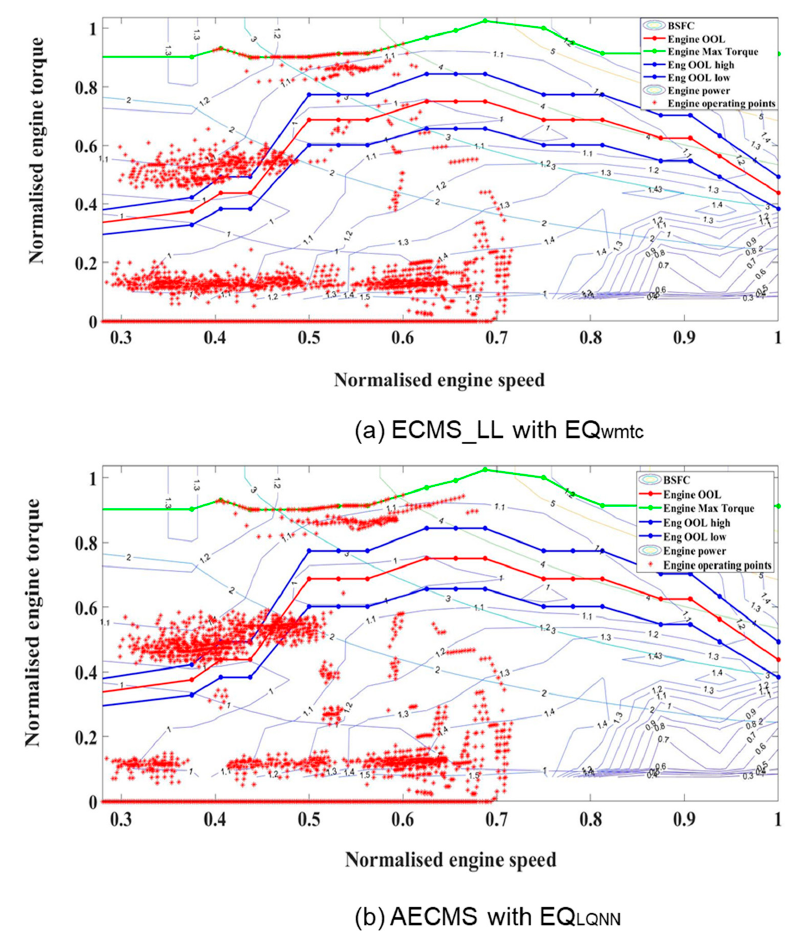
Figure 10. IDC_CD drive cycle with ( a ) ECMS_LL and ( b )